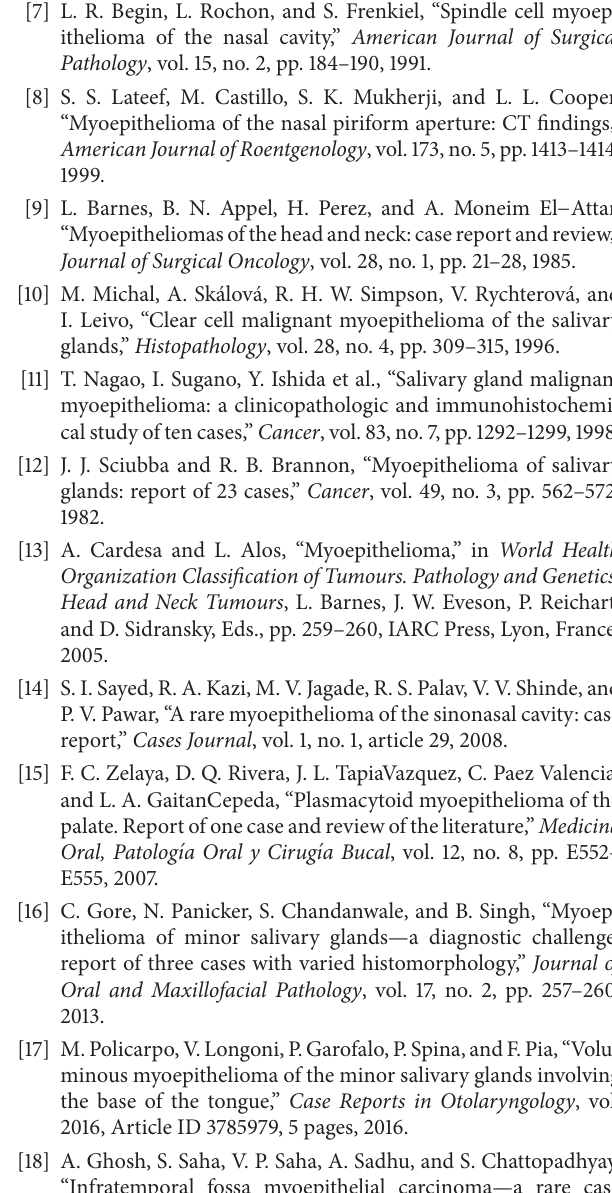
neoplasm is not radio- or chemosensitive and it needs a long- term follow-up since recurrence varied from 35% to 50% and metastasis rates from 8.1% to 25% in different reports [19]. This case had neither recurrence nor metastasis two years after